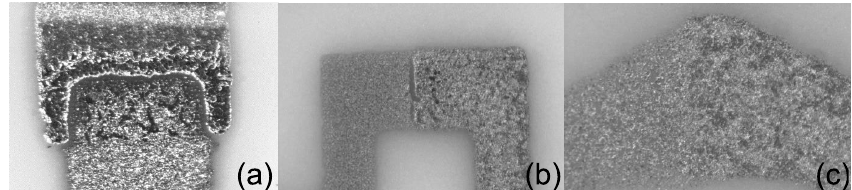
Figure 6. Material diffusion after firing: (a) Ag-Cu dissolution, (b) Pt-PtRh 10 diffusion caused by high sinter activity and (c) reduced Pt-PtRh 10 diffusion after sequential firing.